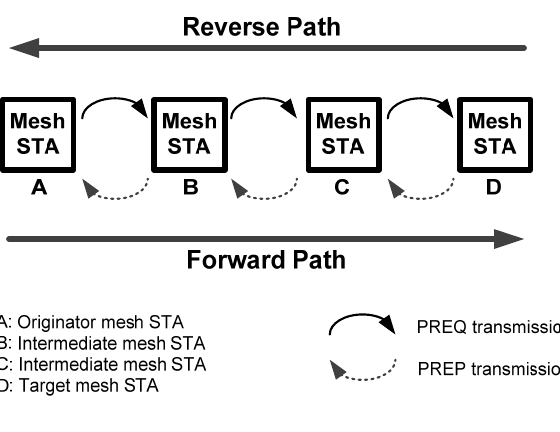
Figure 7. Forward and reverse path formation.